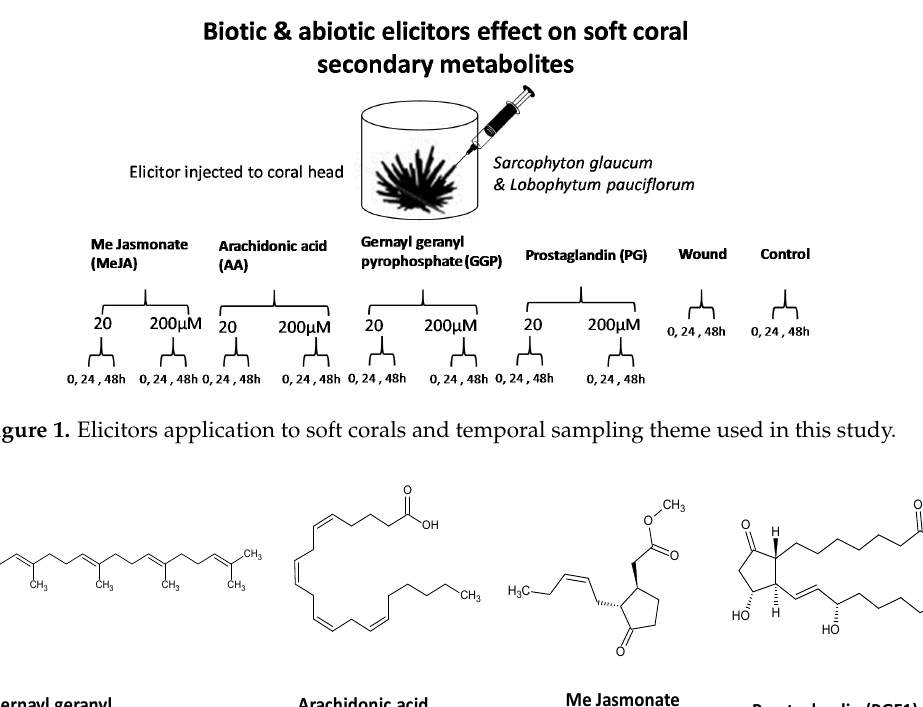
Figure 2. Chemical structure of GGP and the oxylipins used for eliciting soft corals.